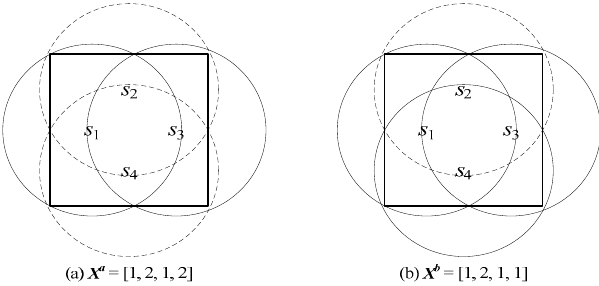
Figure 2. Illustration of the chromosome representation.